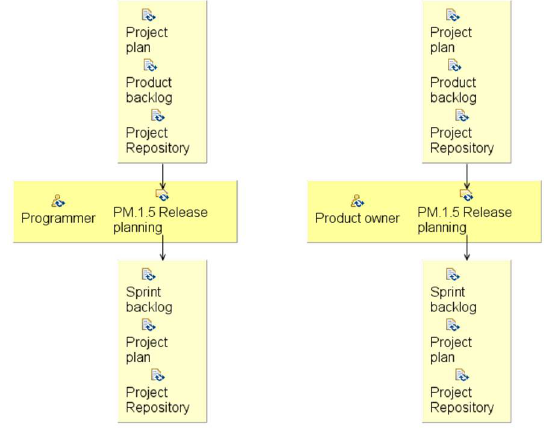
Figure 16. The detailed activity diagram of phrase PM.1.5.